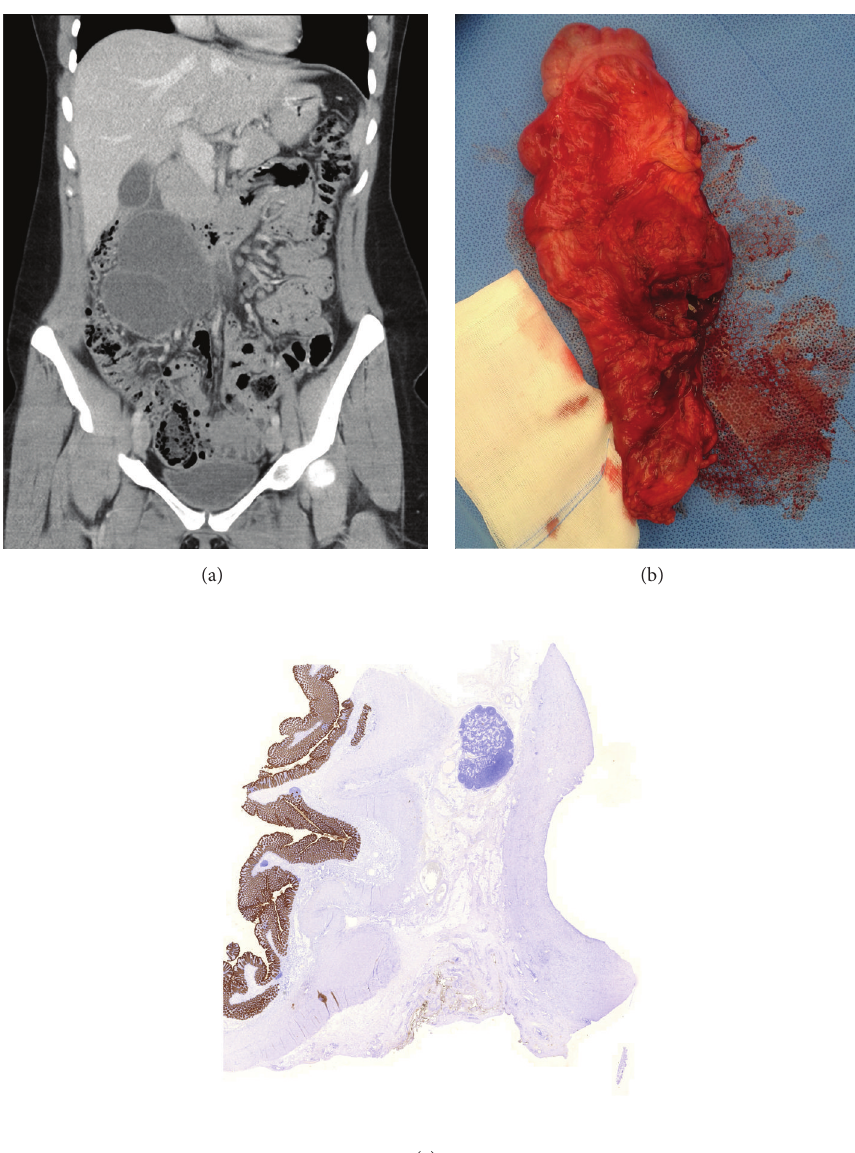
Figure 2: Mesenteric cyst in coronal plane in different viewings. (a) Contrast-enhanced CT. Cystic mass in close relation with surrounding bowel structures. (b) Macroscopic appearance of the resected ascending colon and adjacent mesenteric cyst in the mesenteric fat. (c) Histological appearance of the resected colon (left) and cyst (right). Notice the mesothelial cell specific AE1/AE3 positive (brown colour) cells lining the colon wall, which lacks at the cystic site. This confirms the lack of mesothelial cells in the cyst wall. AE1/AE3 stain, ×